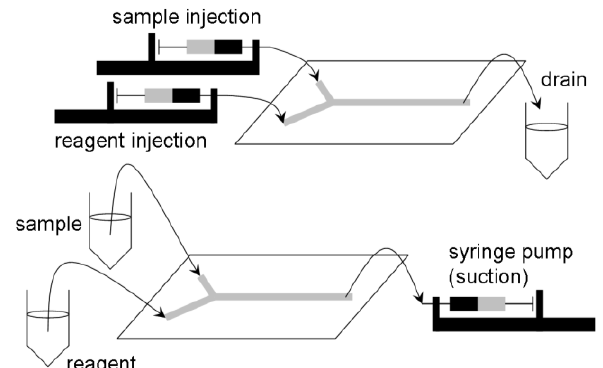
Figure 3. Sample/reagent injection and suction in immunoassay lab-on-a-chip